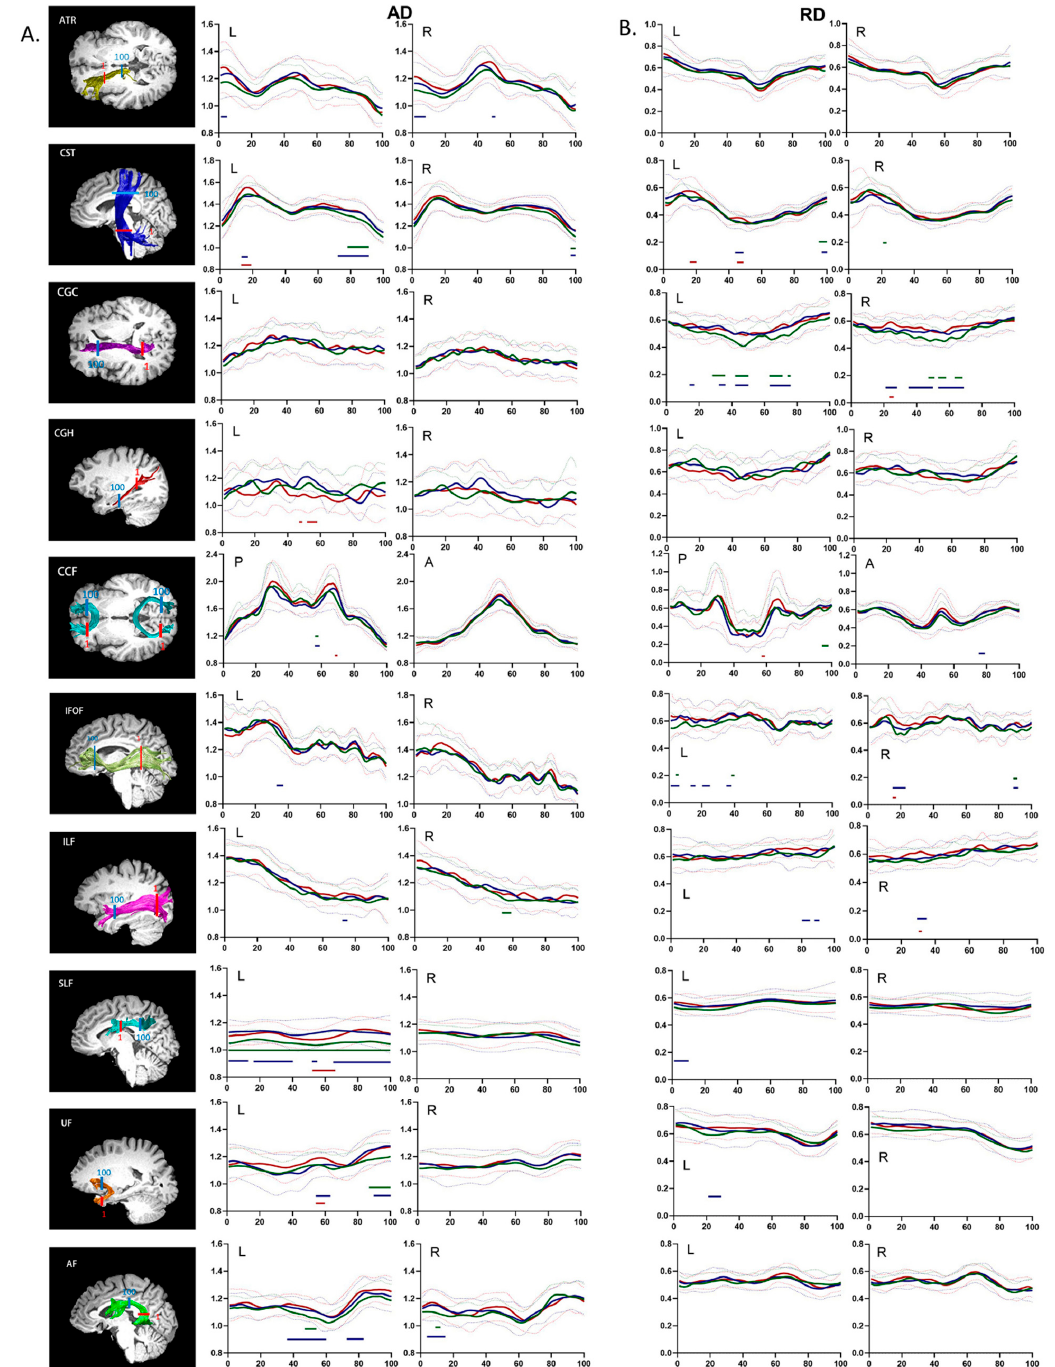
Figure 2. Pointwise comparison of ( A ) axial diffusivity (AD) and ( B ) radial diffusivity (RD) profiles among the HZ, PHN, and HC groups. Notes: The renderings of significantly altered tracts are presented on the T1-weighted images on the left. Red: starting ROIs; blue: ending ROIs. The FA and MD profiles of 20 identified fiber tracts from HZ patients, PHN patients, and HCs (blue, red, and green, respectively) are presented as the mean (SD) (solid line and dotted line, respectively). The color bars under the FA or MD profiles indicate the regions of significant differences between the HZ and HC groups (green), the PHN and HC groups (blue), and the HZ and PHN groups (red). The Y -axis represents the AD or RD values. The X -axis represents the location between the starting and ending waypoint ROIs. Abbreviations: P, posterior; A, anterior; L, left; R,